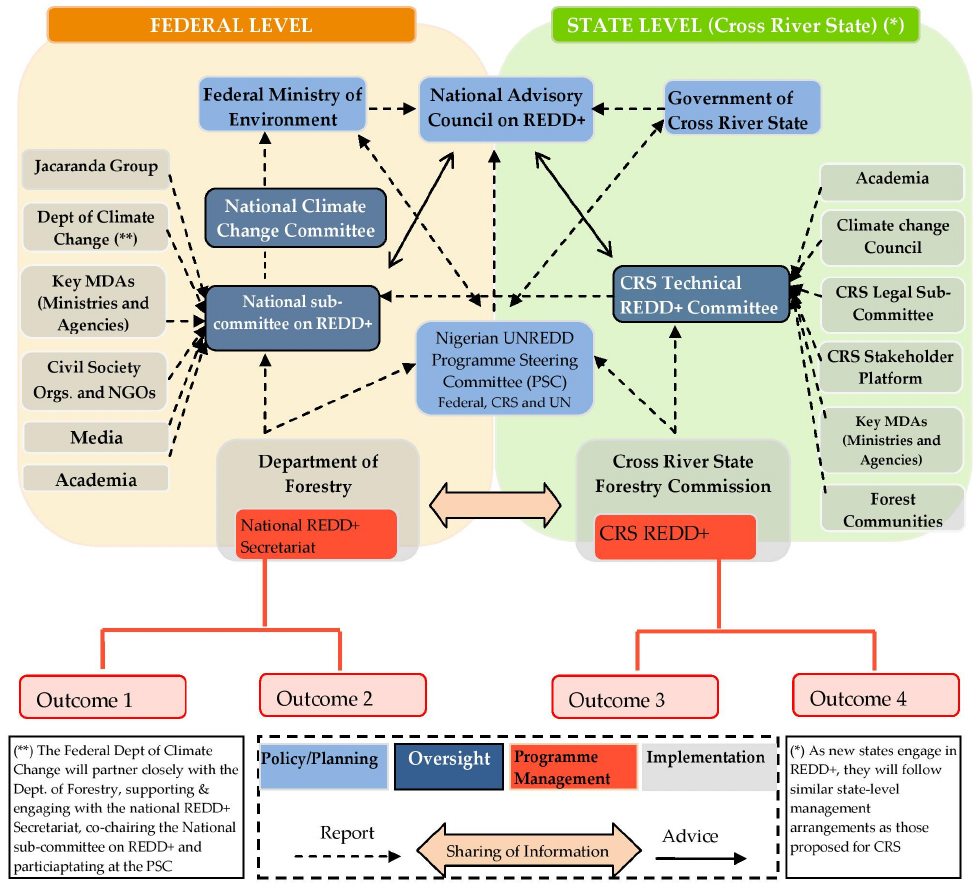
Figure 4. REDD+ Institutional Framework for Nigeria. MDA: Ministries, Departments and Agencies; NGOs: Non-governmental Organisations; CRS: Cross River State; UN: the United States. Source: Adapted from Nigeria R-PP, 2013, p. 11 [66].